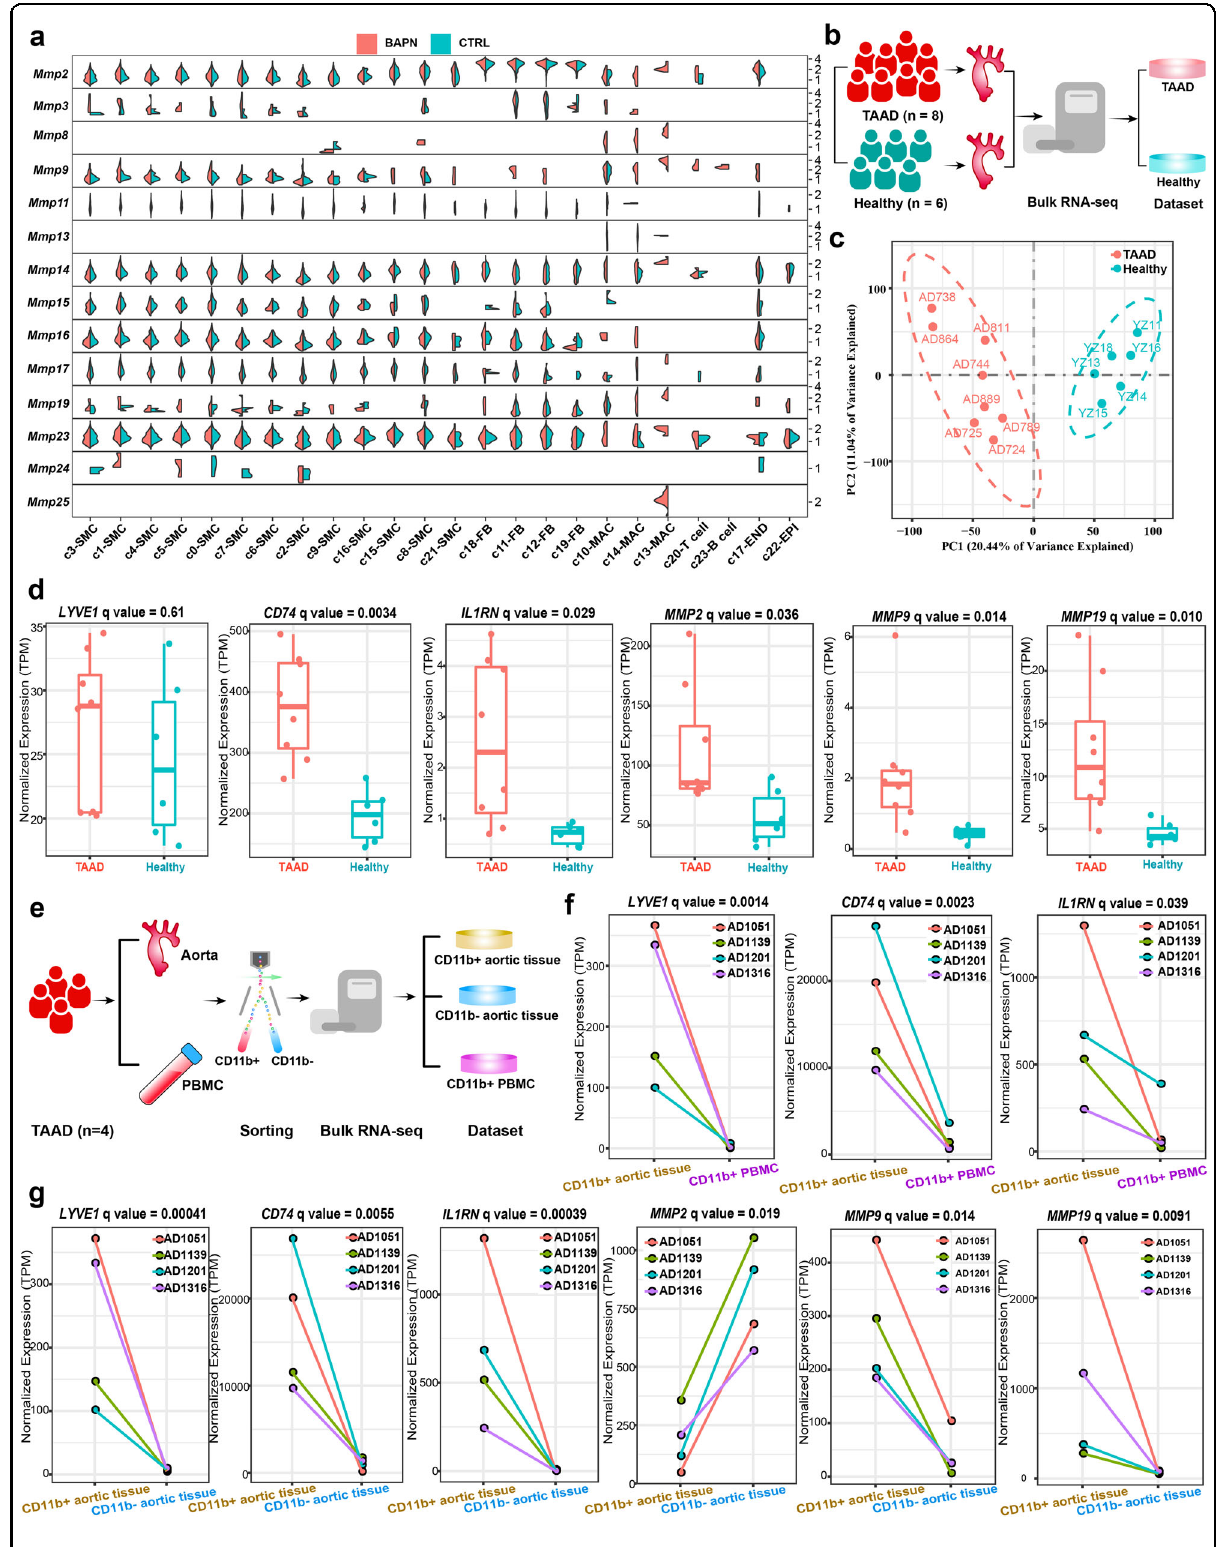
Fig. 6 (See legend on next